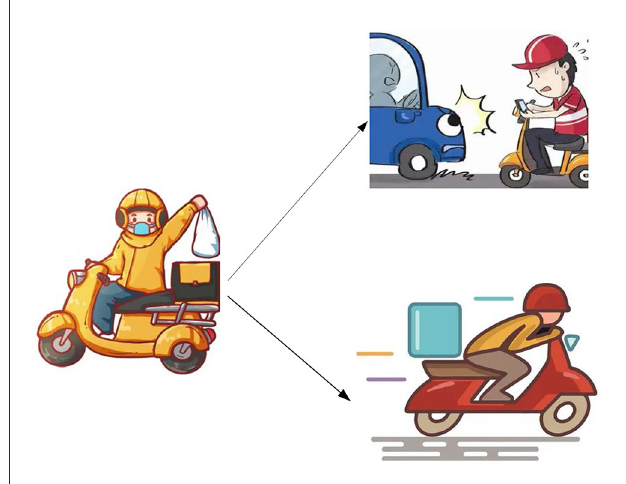
FIGURE1 Examples of occupational injuries of takeout